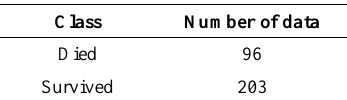
Table 2. Number of data by